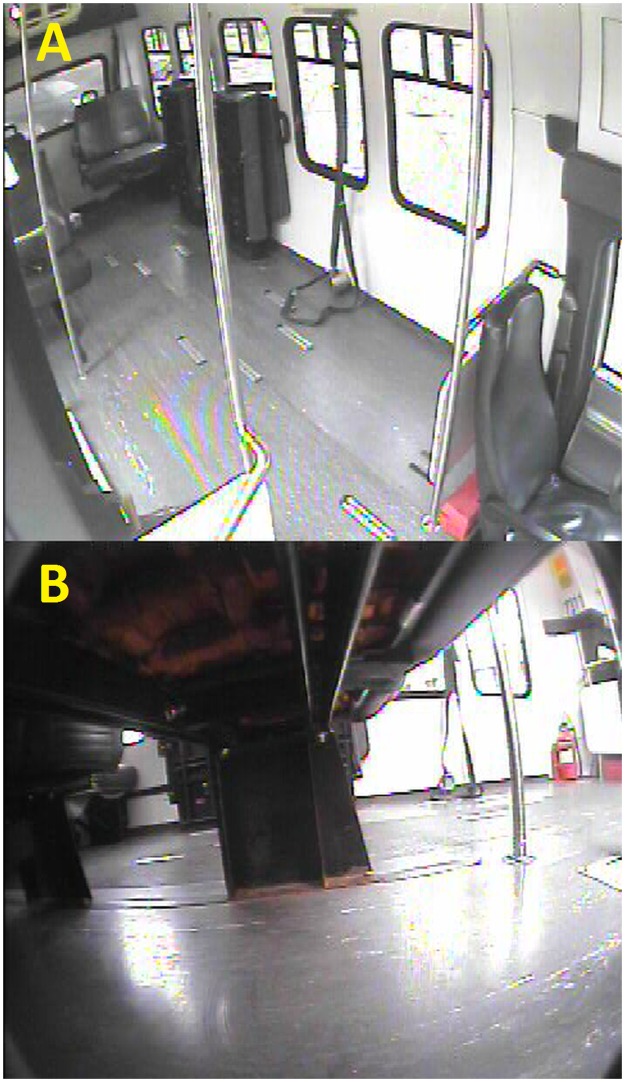
Sample images of WhMD securement station from video surveillance system (AngelTrax®).(A) Overhead view, (B) floor level view.